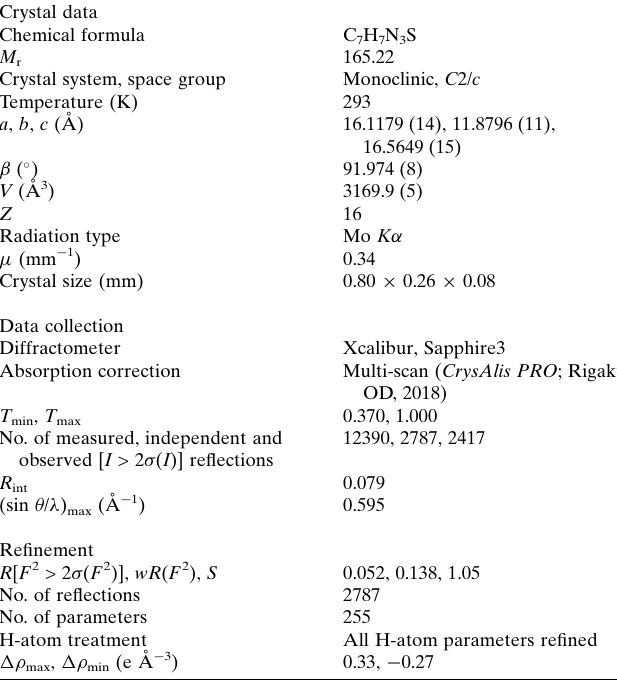
Table 2 Experimental details. Crystal data Chemical